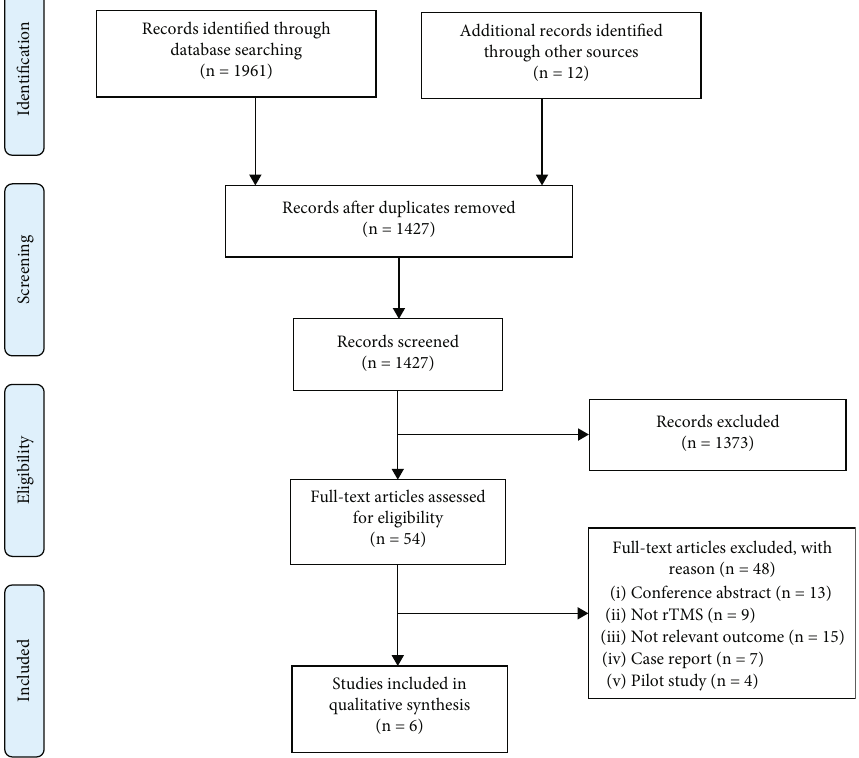
Figure 1: PRISMA fl ow diagram. Table 1: Rating of the PEDro scale and level of